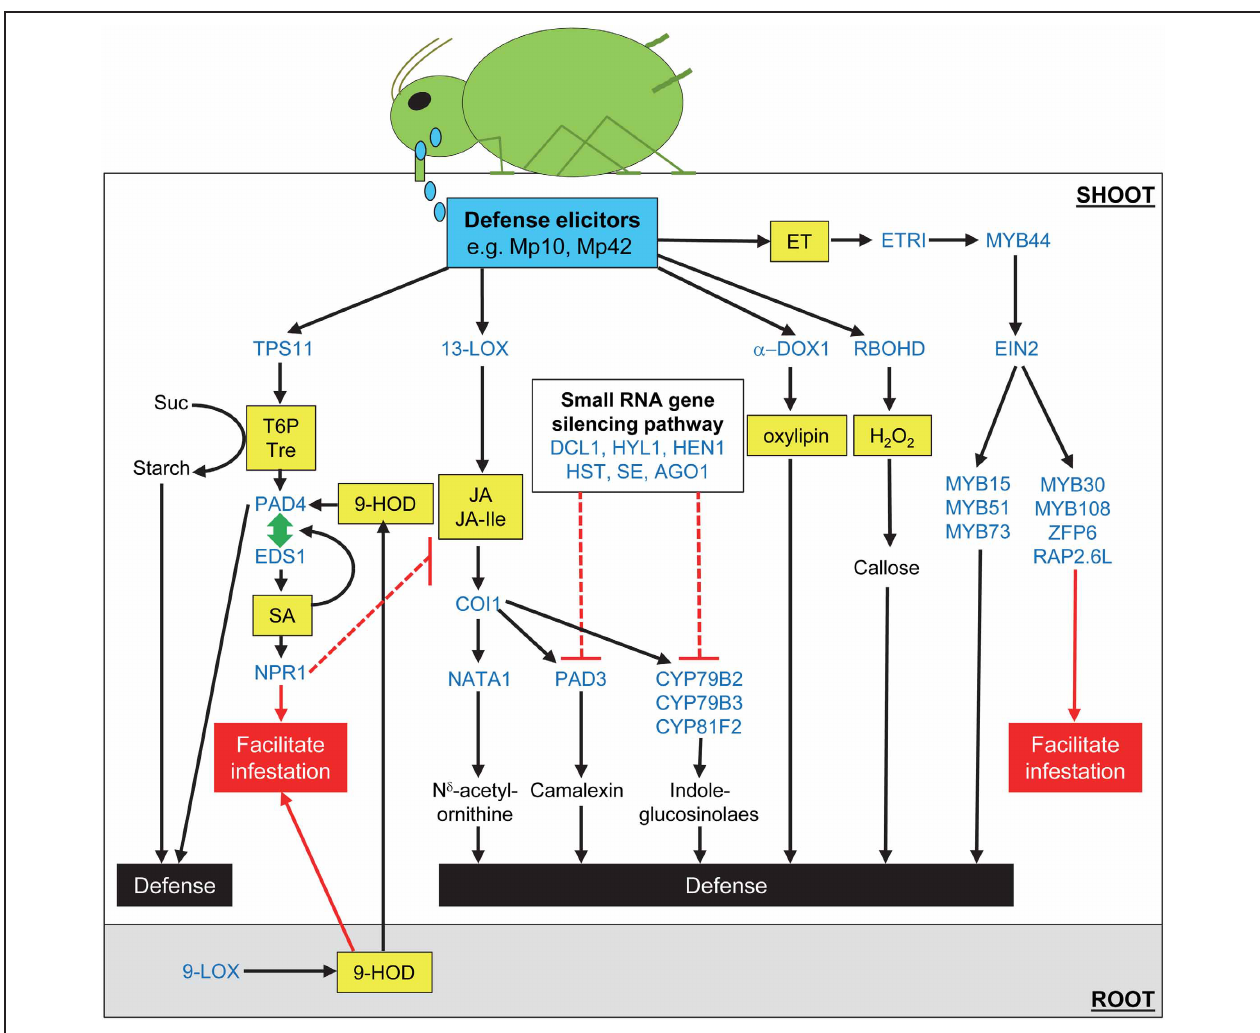
FIGURE 2 | Model depicting relationship between genes and mechanisms that influence Arabidopsis interaction with the green peach aphid. Green peach aphid (GPA) salivary secretions contain effectors that promote infestation, as well as elicitors (e.g., Mp10 and Mp42) that are recognized by the host to turn on defense responses. GPA infestation on the shoot results in the induction of LOX5 expression in roots and a concomitant increase in the levels of LOX5-derived oxylipins (e.g., 9-HOD). LOX5 expression is likely induced by a GPA infestation-induced factor that is translocated from the leaves to the roots. The LOX5 -derived oxylipins are transported from the roots to the shoots where one or more of these oxylipins stimulate expression of the defense regulatory gene, PAD4 . A PAD4 -dependent mechanism adversely impacts GPA settling, feeding and fecundity on Arabidopsis. PAD4 expression is further stimulated by the trehalose (Tre) metabolic pathway. GPA infestation results in the elevated expression of TPS11 , which encodes an enzyme with Trehalose-6-phosphate (T6P) synthase and T6P phosphatase activities that is required for promoting PAD4 expression in GPA-infested plants. TPS11 also promotes accumulation of starch at the expense of sucrose (Suc), which is a major feeding stimulant, thereby generating a secondary sink that is detrimental to the insect’s ability to colonize Arabidopsis. TPS11 and PAD4 are also required for accumulation of an antibiosis factor in the petiole exudates that limits insect fecundity. However, the GPA has evolved mechanisms that over time spent on the plant suppress this TPS11 / PAD4 -determined antibiosis activity. The GPA has also evolved to utilize one or more of the 9-LOX-derived oxylipins, or products thereof, as cues to stimulate feeding from phloem and xylem, and enhance